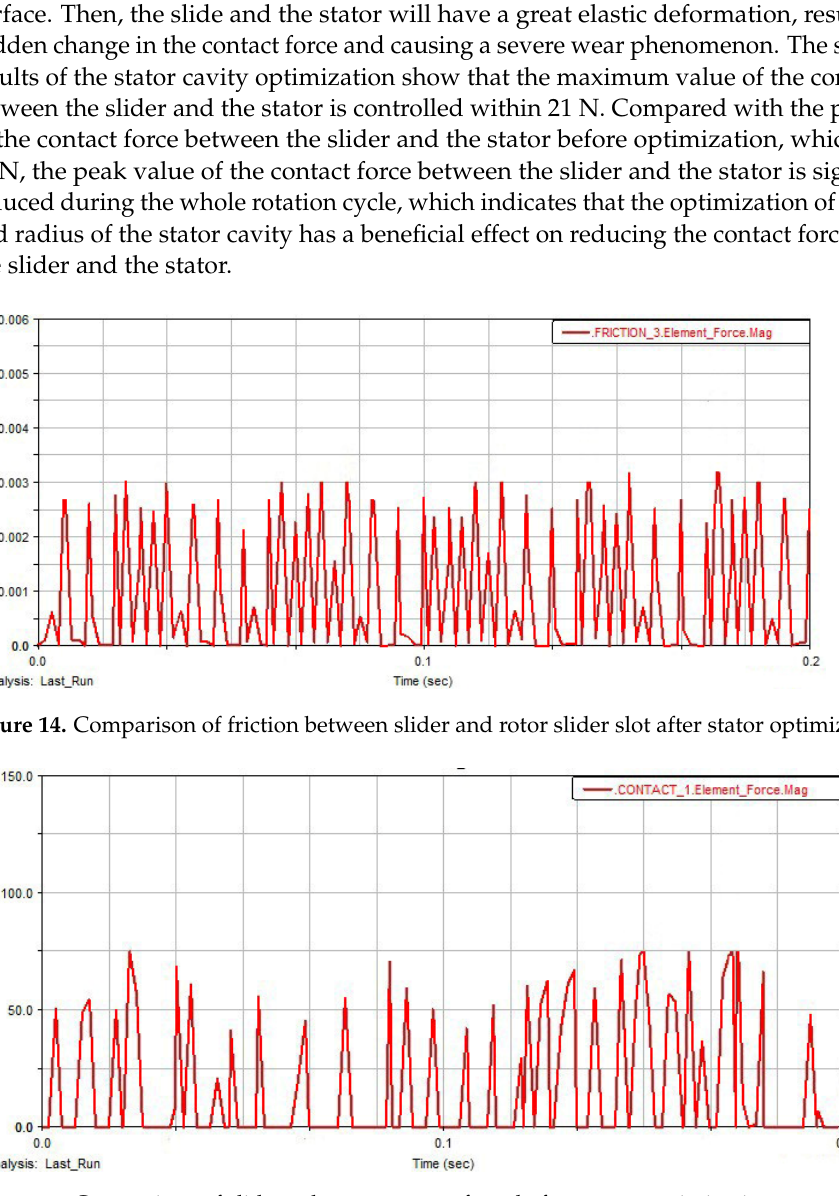
Figure 15. Comparison of slide and stator contact force before stator optimization.